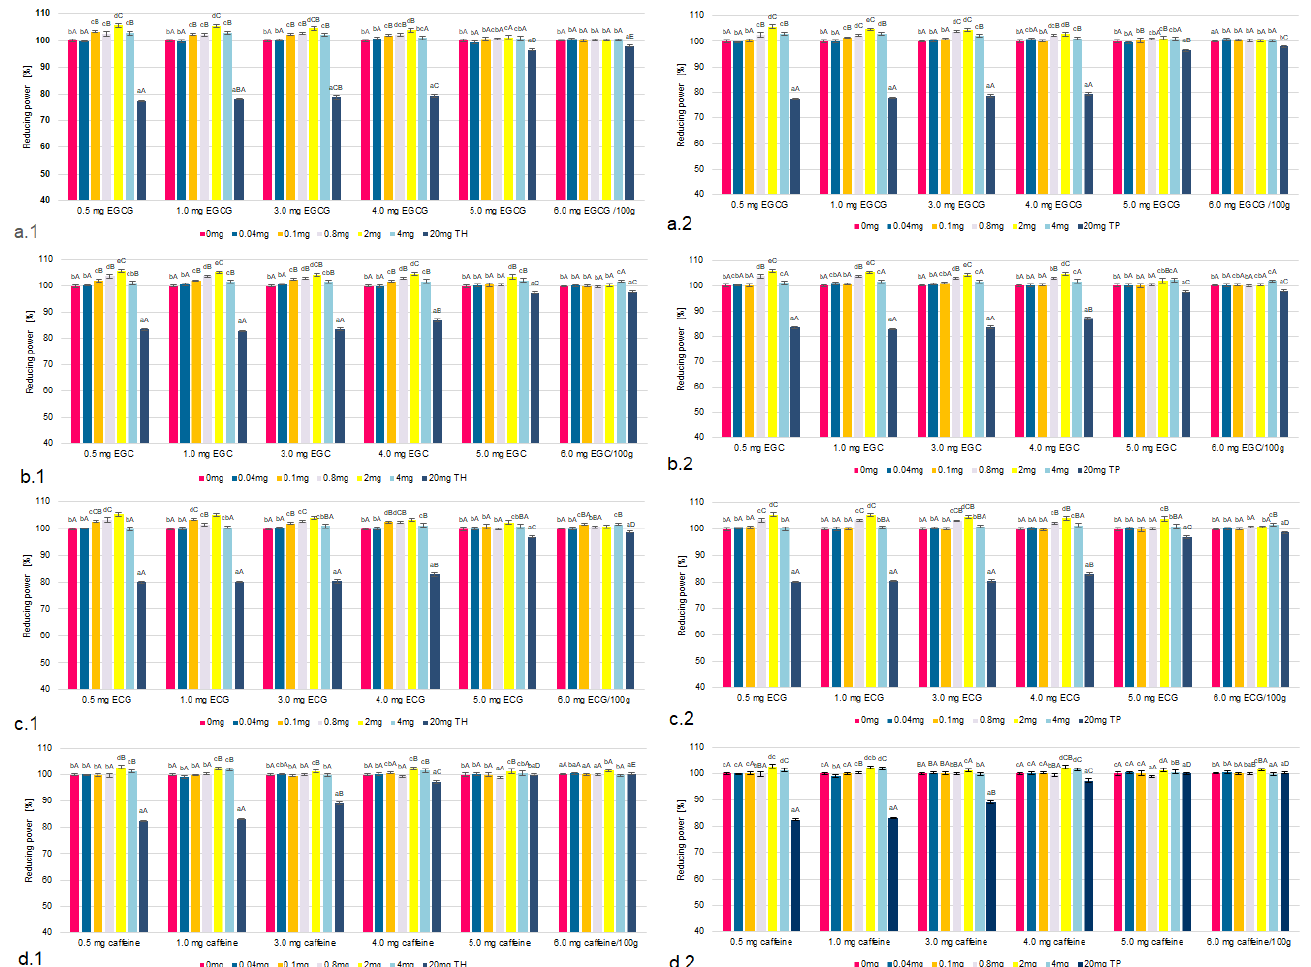
Figure 2. The reducing properties of EGCG ( a ), EGC ( b ), ECG ( c ) and caffeine ( d ) in the models with TH ( 1 ) and TP ( 2 ), compared to a sample without thiamine; different letters (lower letters in the same concentration of antioxidant; bold letters in the same concentration of thiamine denote a significant difference at p < 0.05 (one-way ANOVA, and post hoc Tukey test).